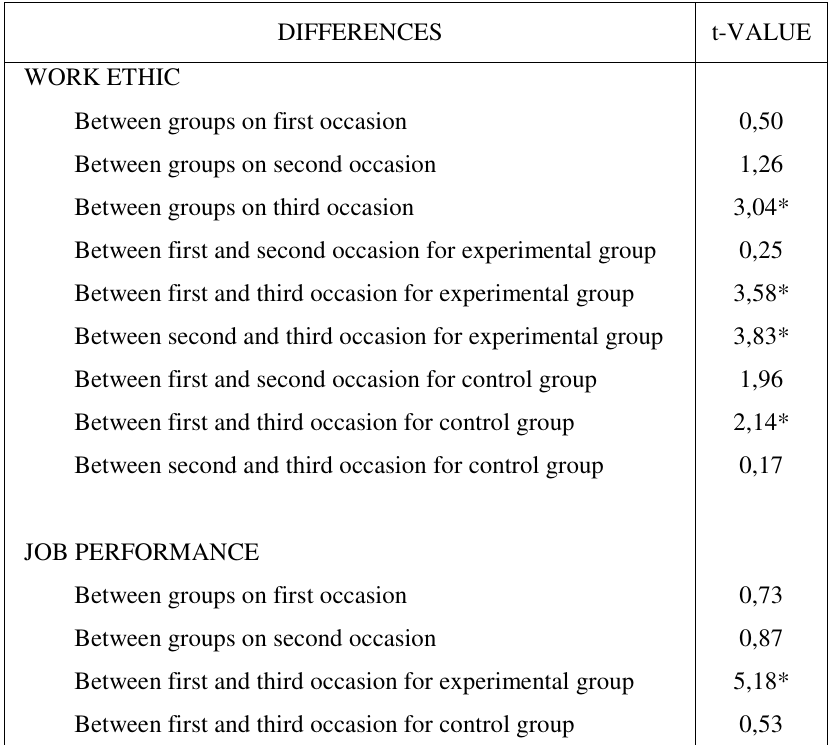
RESULTS OF t-TESTS ON WORK ETHIC AND JOB PERFORMANCE DATA